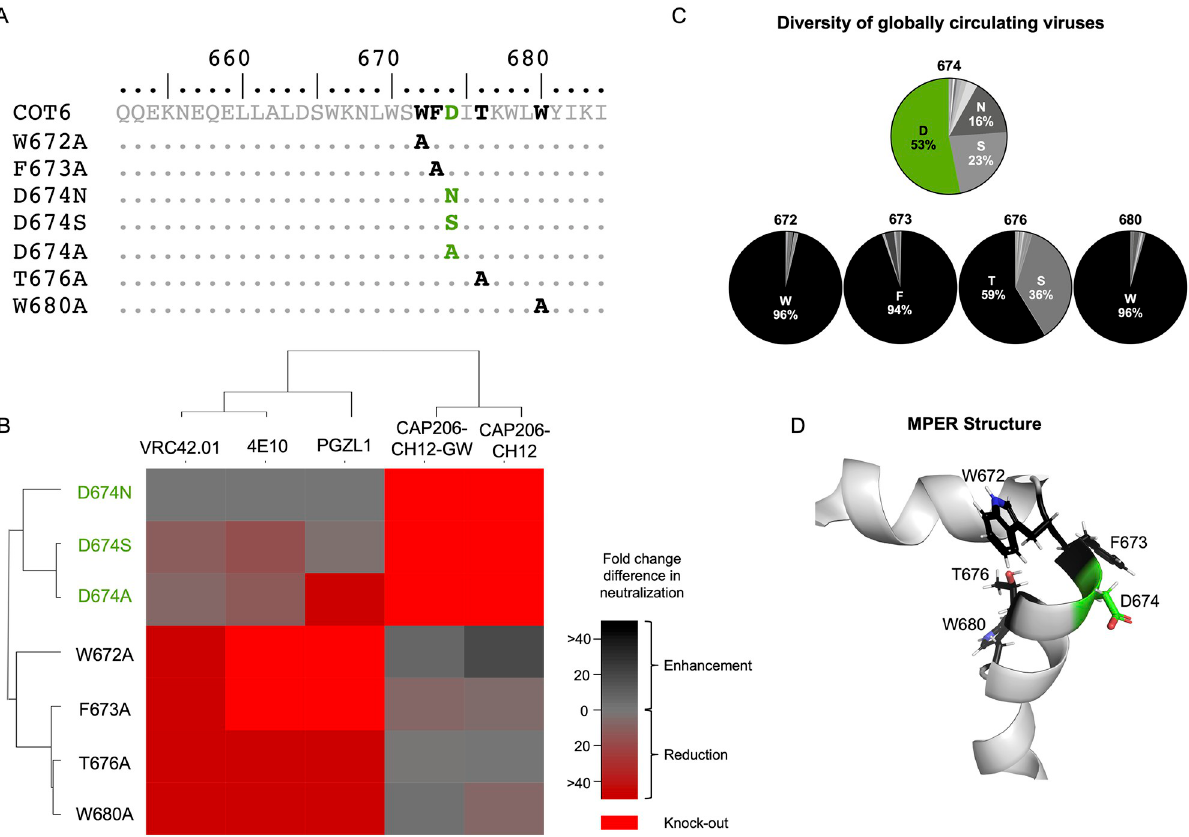
Fig 5. CAP206-CH12 lineage is dependent on the highly variable D 674 residue. (A) MPER sequence alignment of mutations introduced into the MPER of the COT6 virus (sensitive to CAP206-CH12, VRC42.01, PGZL1 and 4E10). Highlighted in black are key amino acid residues for VRC42.01, PGZL1 and 4E10 and in green are key residues for CAP206-CH12 neutralization. (B) Heat map showing the fold change differences in neutralization between COT6 wild-type and mutant viruses (represented by the rows) for VRC42.01, 4E10, PGZL1, CAP206-CH12, and CAP206-CH12-GW. Red represents reduction or loss of neutralization against the mutant, and black represents increased neutralization against the mutant. (C) Pie charts representing the relative frequency of amino acid residues at positions 674 (CAP206-CH12 dependent residue shown in green), 672, 673, 676, and 680 (VRC42.01, PGZL1, and 4E10 dependent residues are shown in black) based on 7,510 MPER sequences, representing all HIV group M subtype sequences from the Los Alamos Database (www.hiv.lanl.gov). (D) Schematic representation of the MPER “turn” and “kink” structure [29] with key residues for the CAP206-CH12 lineage shown in green and those for VRC42.01 and 4E10 shown in